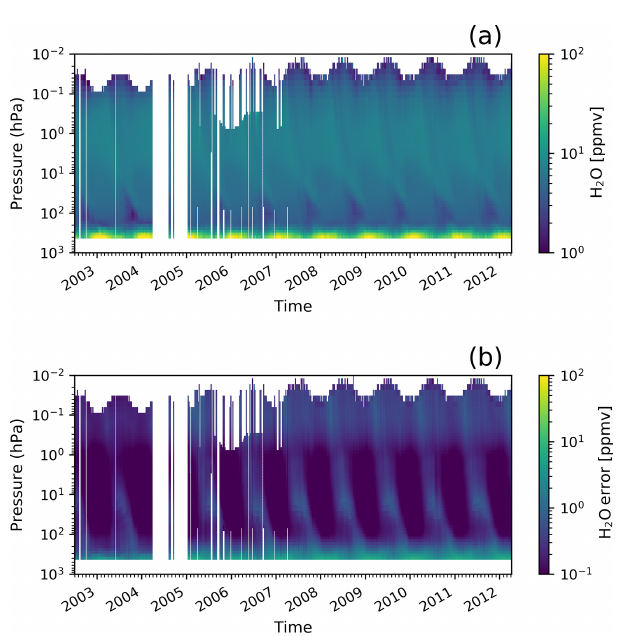
Figure 20. (a) Time series of monthly mean V8 H 2 O profiles in the latitude belt from 60 to 90 ◦ S and (b) corresponding retrieval error profiles when altitude- and latitude-dependent CI profiles are used.